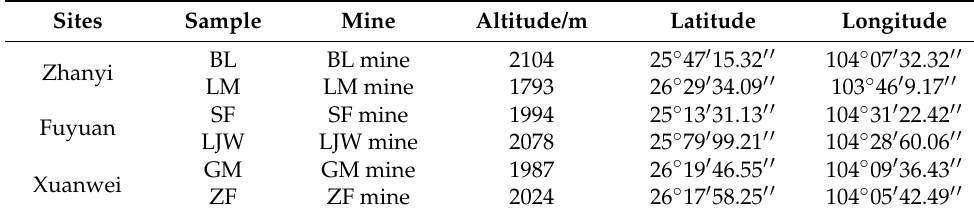
Table 1. Residential coal samples information.